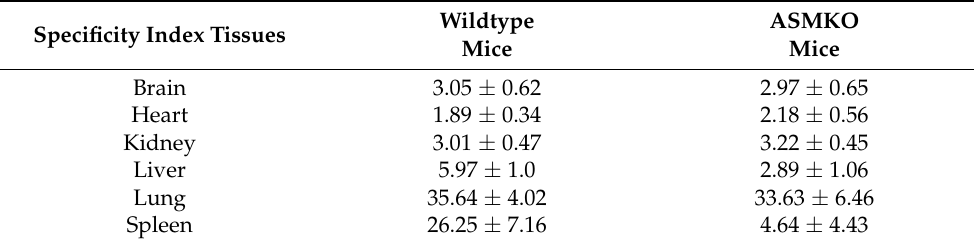
Table 5. Specificity index of NP-coated acid sphingomyelinase (ASM) over free ASM in mouse models. Specificity Index